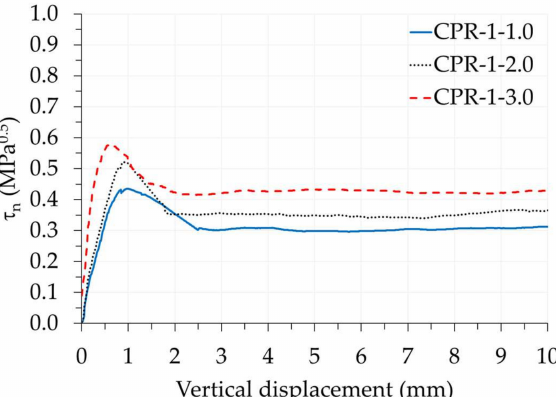
Figure 14. Normalized shear stress versus relative vertical displacement curves for the single-keyed RAC dry joint